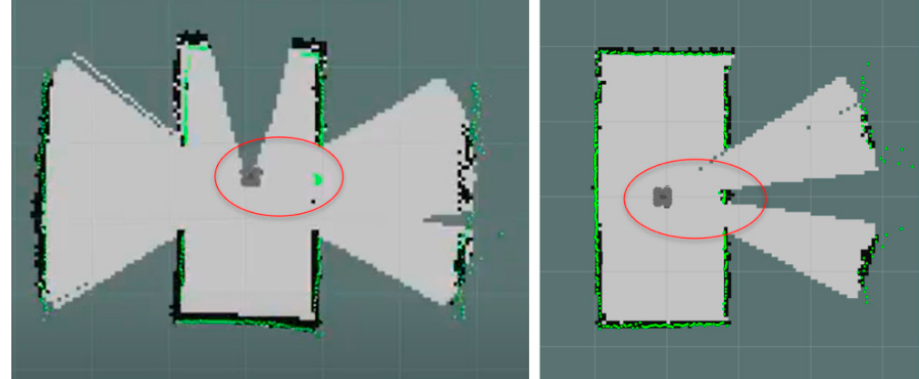
Figure 14. Observation of the reflected boundary detected behind the surface of the mirror.